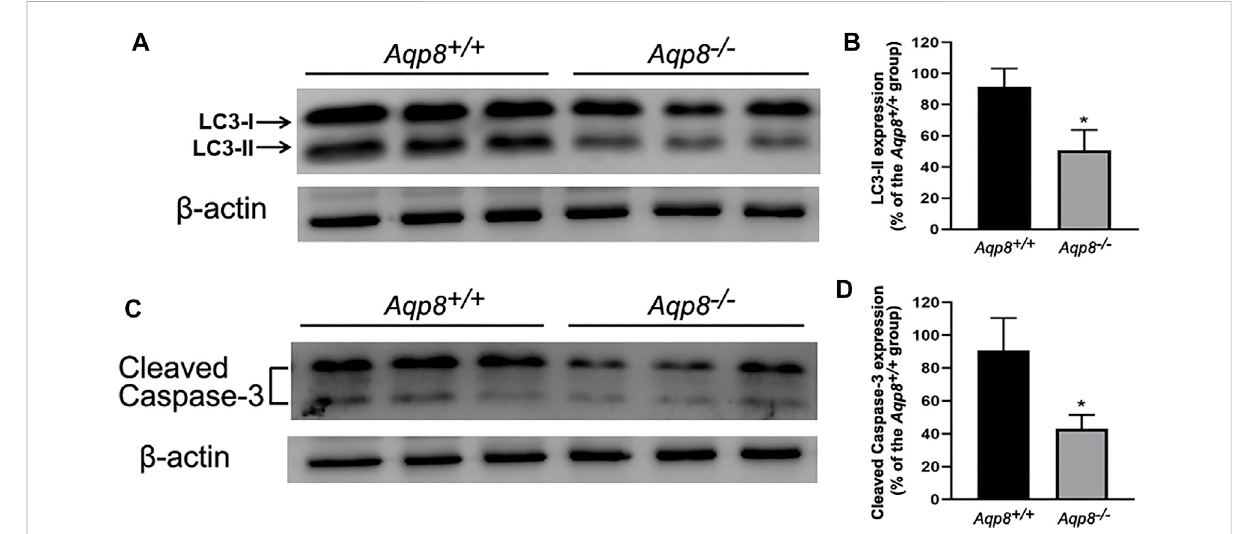
FIGURE 1 Autophagy and apoptosis decrease in Aqp8 − / − mouse follicular granulosa cells. The expressions of cleaved caspase-3 and LC3-II proteins in granulosa cells from Aqp8 +/+ and Aqp8 − / − mice. Densitometric quanti fi cation and representative immunoblots of LC3 proteins (A,B) or cleaved caspase-3 (C,D) . Experiments were repeated three times, and data were expressed as mean ± SD. * p < 0.05 were considered statistically signi fi